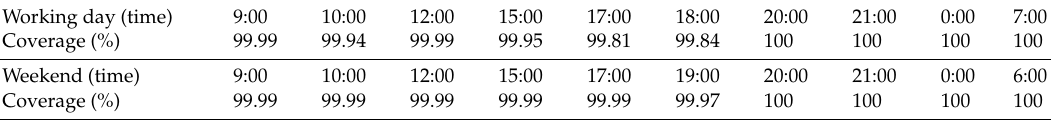
Table 2. The coverage of emergency medical facilities at di ff erent